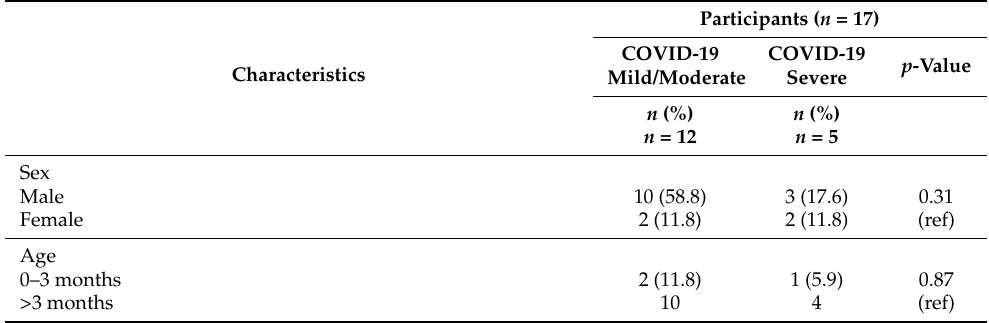
Table 3. Identification of risk factors for severe outcome in COVID-19 children (mild vs. severe